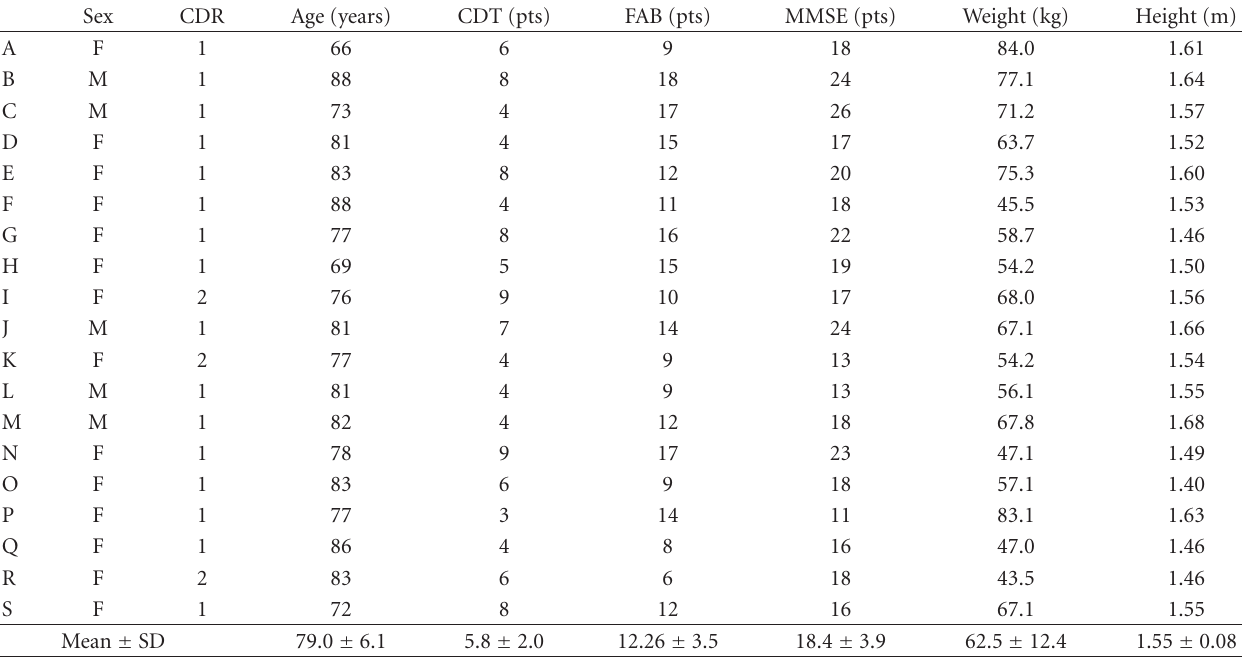
Table 1: General, clinical, and anthropometric characteristics of each